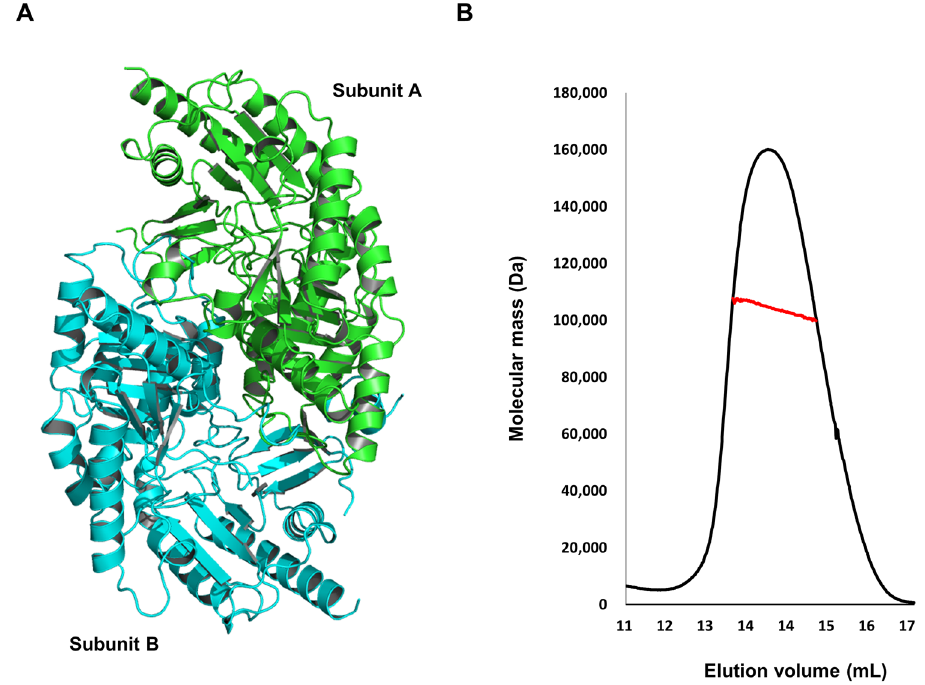
Figure 1. Dimeric structure of ω -transaminase from Vibrio fluvialis JS17 (Vfat). ( A ) Overall dimeric structure of Vfat. The individual subunits are shown in different colors. ( B ) MALS data. The red line indicates the experimental data.